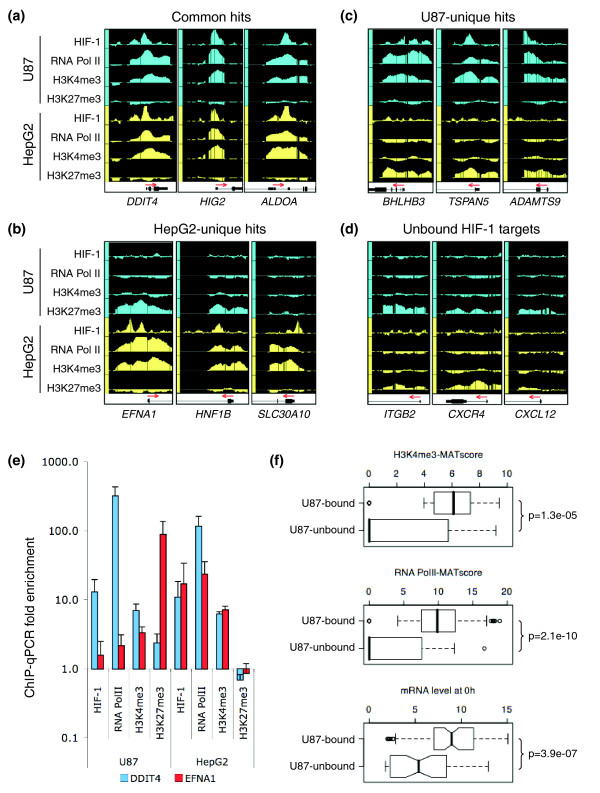
Cell-type specific gene expression predicts HIF-1 binding. For the indicated genes, IGB tracks for HIF-1, RNA Pol II, H3K4 me3 and H3K27 me3 are shown with identical scales between cell types. Representative data are shown for (a) HIF-1 hits common to both cell types, (b) HIF-1 ChIP hits unique to HepG2 or (c) U87 cells, and (d) HIF-1 binding sites reported in the literature but not bound in either cell type. (e) ChIP-qPCR analysis of HIF-1, H3K4 me3, RNA Pol II, and H3K27 me3 at the indicated loci. For HIF-1, H3K4 me3, and RNA Pol II ChIP, results are normalized to negative control regions located 5 kb and 10 kb upstream of the vascular endothelial growth factor (VEGF) gene. For H3K27 me3 ChIP, results are normalized to the promoter regions of the glyceraldehyde 3-phosphate dehydrogenase (GAPDH) and aldolase A (ALDOA) genes. Data expressed as mean ± SD of independent replicates. (f) A set of well-validated HIF-1 target genes were partitioned based on whether HIF-1 binding was observed (U87-bound) or absent (U87-unbound) in U87 cells. Binding of HIF-1 is highly correlated with H3K4 me3 modification, RNA Pol II occupancy, and basal mRNA production. Statistical significance was determined by Student's t-test. For box plots, the median is indicated by a dark bar, the box bounds the lower and upper quartiles, the whiskers define the data range, and the notches represent the 95% confidence interval.